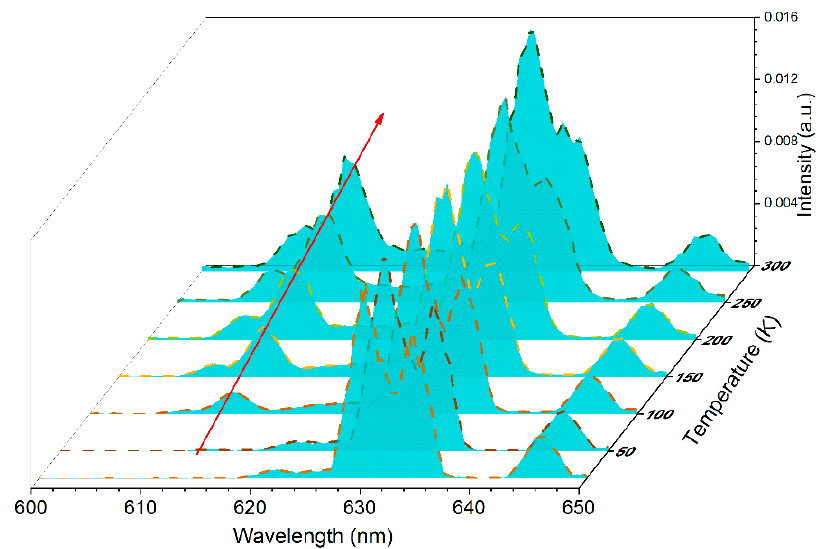
Figure 7. Temperature-dependent PL spectra of [N(CH 3 ) 4 ] 2 ZrF 6 :1%Mn 4+ in the range from 13 to 295 K.